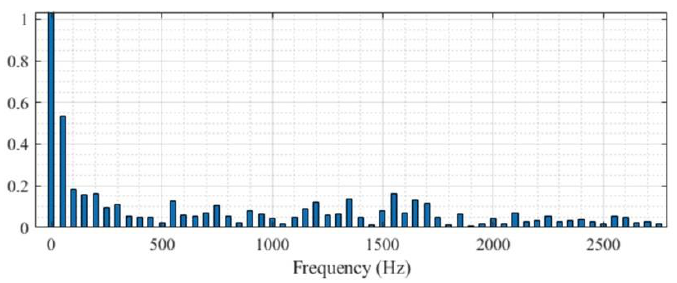
Figure 4. A-phase current FFT analysis.